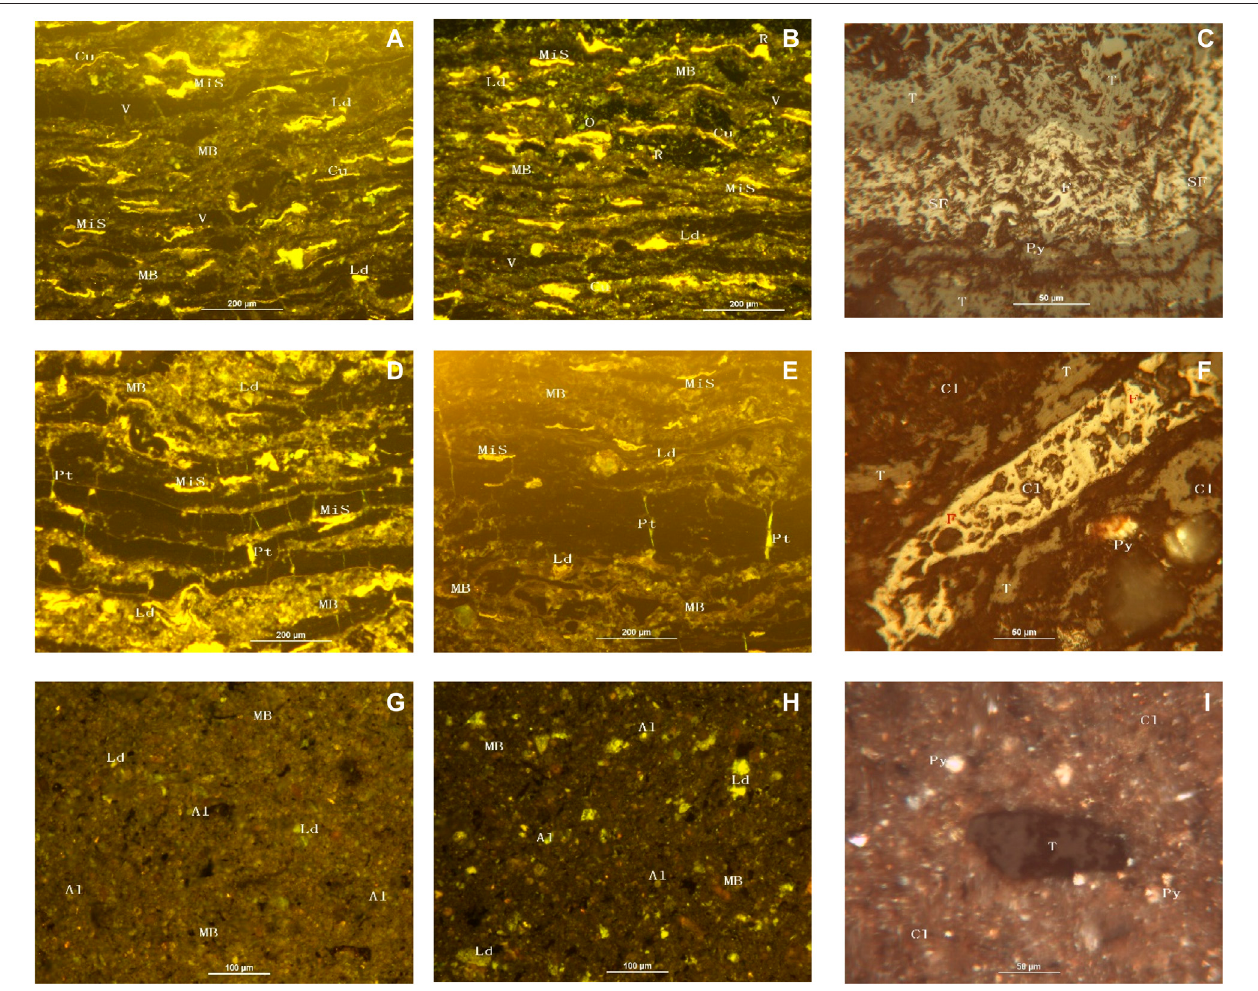
FIGURE2| PhotomicrographsofmaceralsforC 1 s b sourcerockinthesoutheasternJunggar;Note:clayminerals(Cl);mineralbituminous(MB);microsporinite(Mis); vtrinite (V); liptodetrinite (Ld); cutinite (Cu); resinite (R); oil satins (O); telinite (T); semi-fusinite (SF); fusinite (F); Pyrite (Py); asphaltenite (Pt); alginate (Al). (A – C) demonstrate the coal sample from well J15 (2,860 m, core). (D – F) demonstrate the carbonaceous mudstone sample from well J3301 (4,135 m, cuttings). (G – I) demonstrate the carbonaceous mudstone samplefrom wellJ3301(4441 m,core). (A,B,D,E,G,H) areinspired byblue light(re fl ected fl uorescence). (C,F,I) areinspiredbyre fl ected light (oil